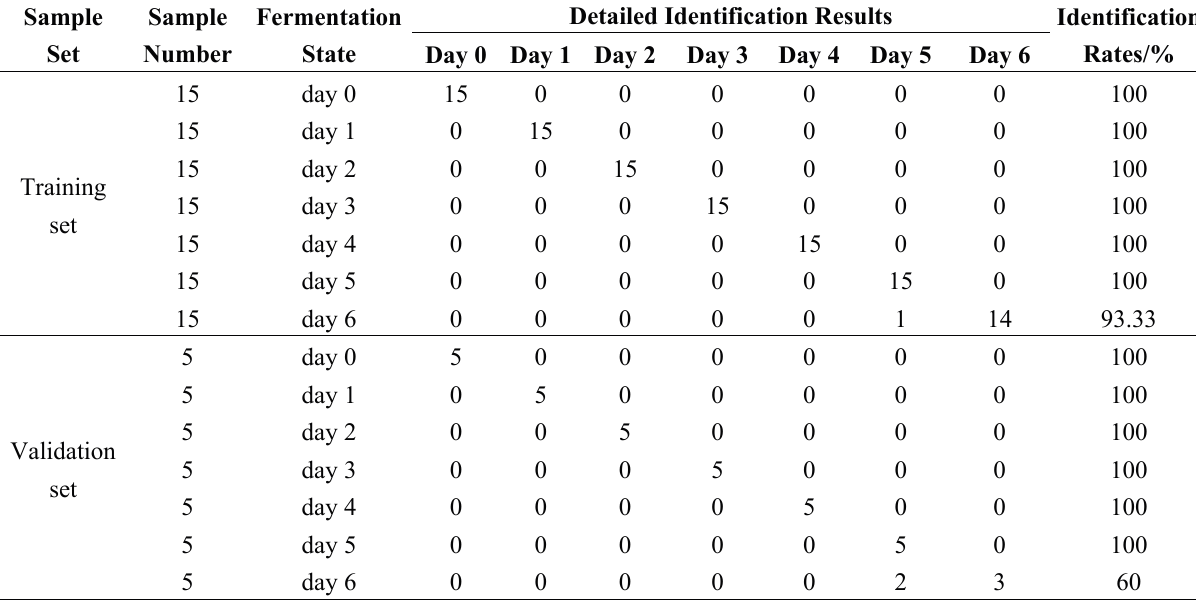
Table 1. Detail identification results of the best fusion model in the training and validation sets.